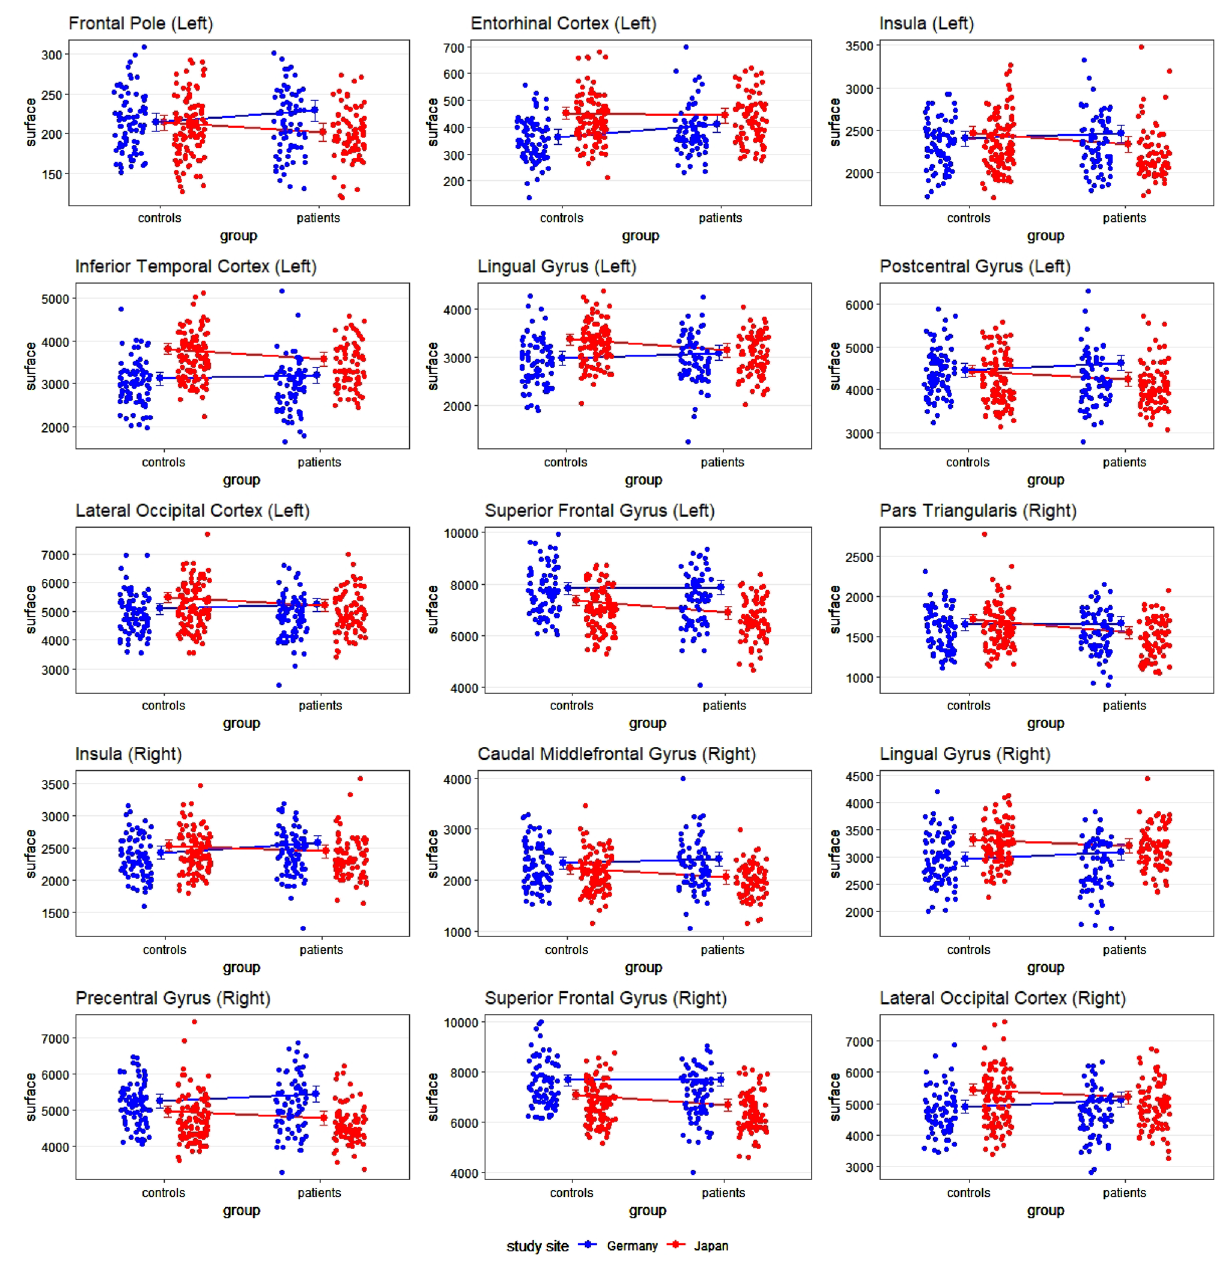
Figure 2. Scatterplots depicting the interaction between group and site with cortical surface area as dependent variable. The small dots represent the individual values per participant; the lines connect the estimated means (i.e., the output of the regression). Error bars indicate the 99% confidence